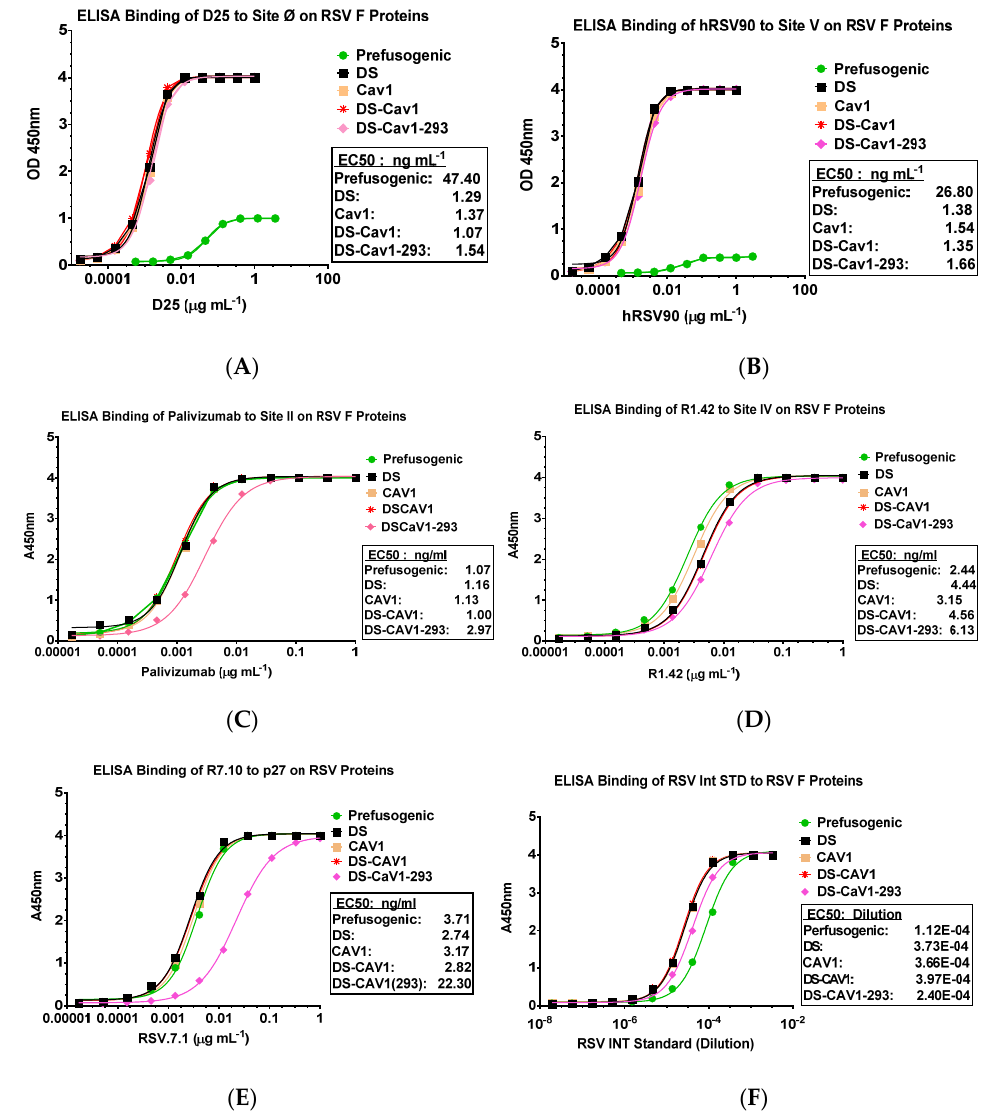
Figure 2. Antigenic site-specific monoclonal antibody binding to prefusogenic F and prefusion F variants. Enzyme-linked immunosorbent assay (ELISA) binding curves monoclonal antibodies ( A ) D25 (site Ø), ( B ) hRSV90 (site V), ( C ) palivizumab (site II), ( D ) R1.42 (site IV), ( E ) R7.10 (p27), and ( F ) human RSV international standard (RSV Int Std).